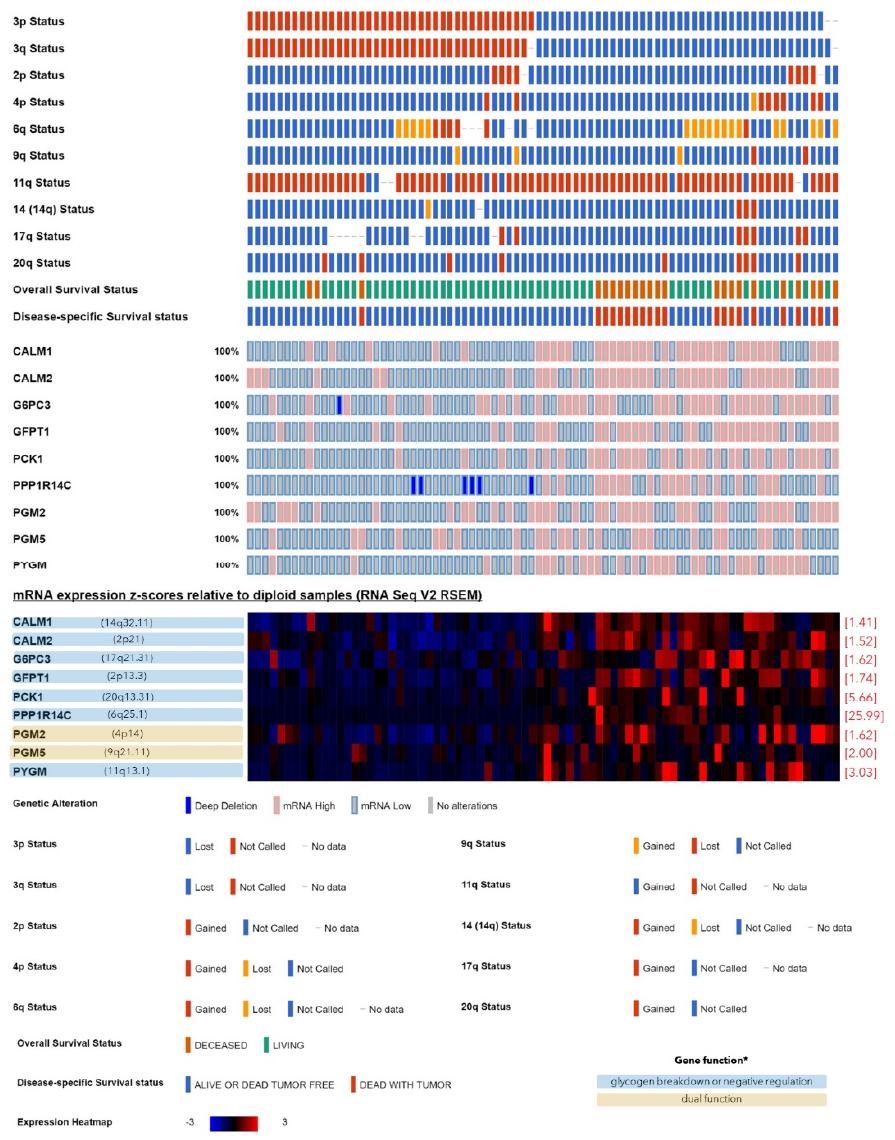
Figure 3. Genes involved in glycogen metabolism that exhibited a higher expression in the monosomy-3 tumors of the TCGA-UM cohort (n = 80 patients) regardless of the gene copy number. The tumor samples, which are represented by the columns, were aligned according to the copy numbers of chromosome 3p and 3q (red: normal, blue: loss) in the uppermost two rows. Tumors with the loss of both 3p and 3q were defined as having monosomy-3, while this data was incomplete for n = 3 samples. The copy number of the chromosomes that harbor the remaining genes of interest, as well as the survival status are also illustrated in the upper rows, whereas the middle rows demonstrate the presence of genetic alterations. The expression heatmap in the lower rows was established from the mRNA z-scores, with blue and red indicating mRNA levels that were up to three standard deviations lower or higher than the mean, respectively, whereas black denotes an expression at the mean. The loci of the analyzed genes are stated in parentheses next to the gene symbol in the heatmap. The fold changes are listed in square brackets on the right-hand side of the heatmap. Genes that negatively regulate the glycogen production are highlighted with a blue background whereas the genes that are involved in both the synthesis and breakdown of glycogen are indicated in yellow.